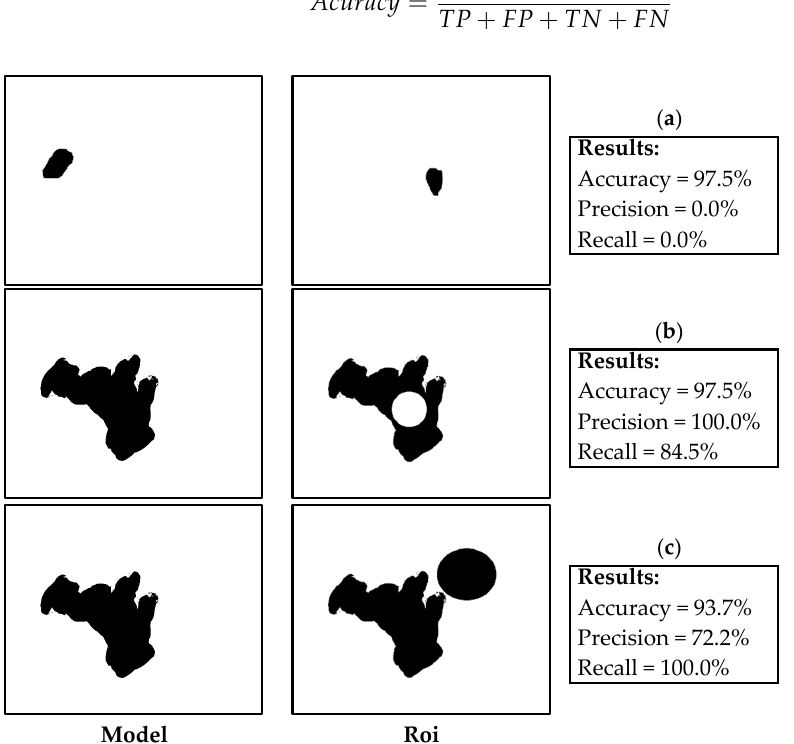
Figure 4. Example of confusion matrix results considering the zone of interest obtained from a real image ( model ) and the zone of interest obtained by tomography ( Roi ) considering conditions for better results of accuracy ( a ), precision ( b ) and recall ( c ).